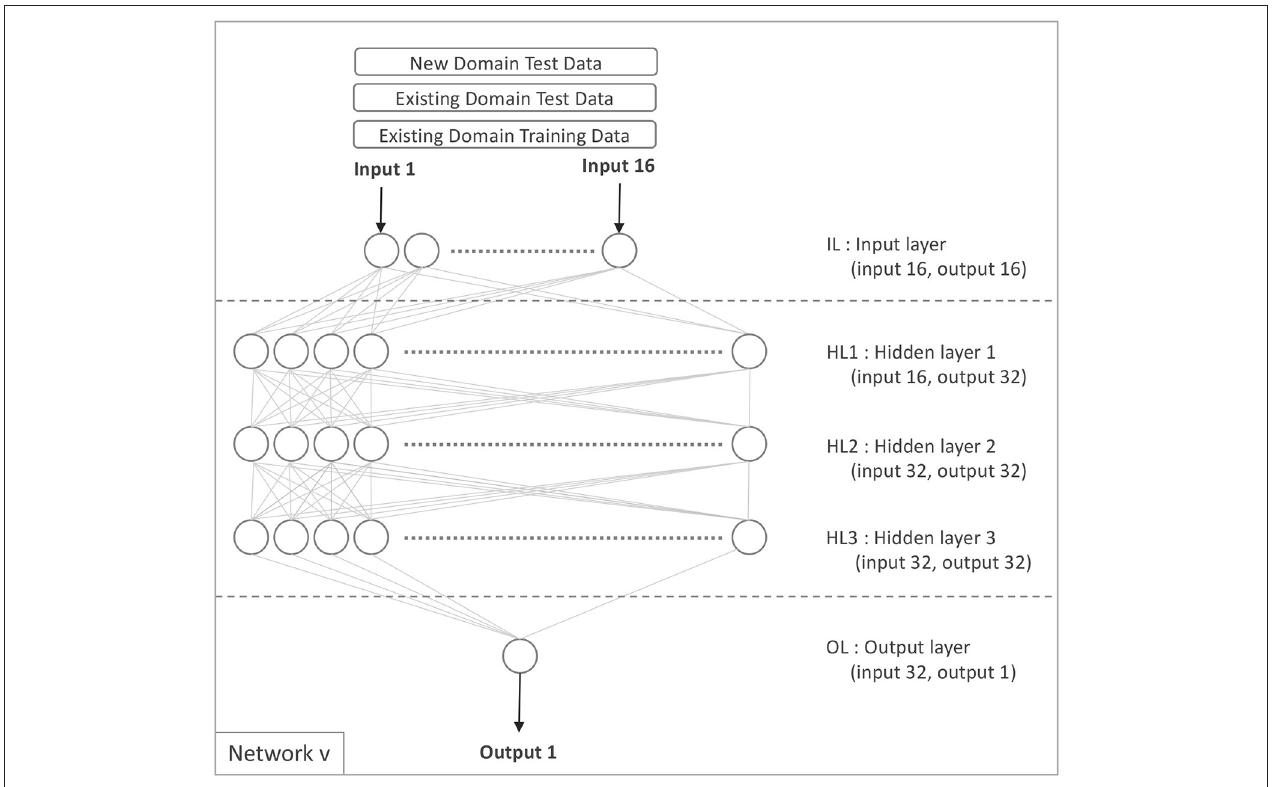
FIGURE 2 | Network